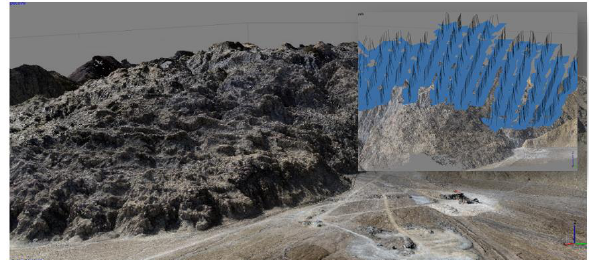
Figure 4: UAV Photogrammetry is only solution for surface mapping of hazardous area. The corner figure shows the 3D (not 2D) flight lines of aerial